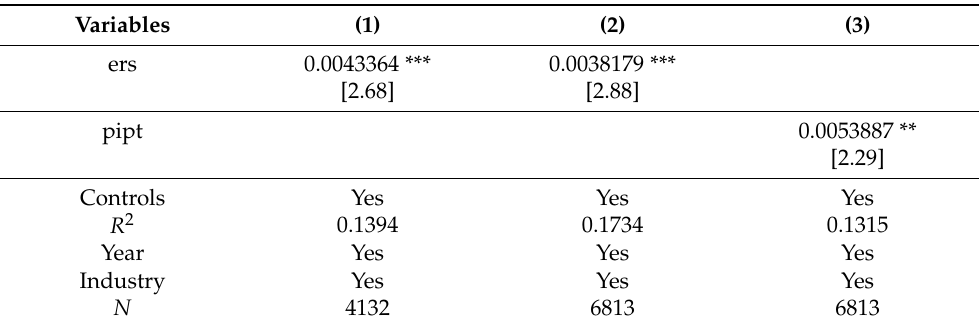
Table 7. Robustness test